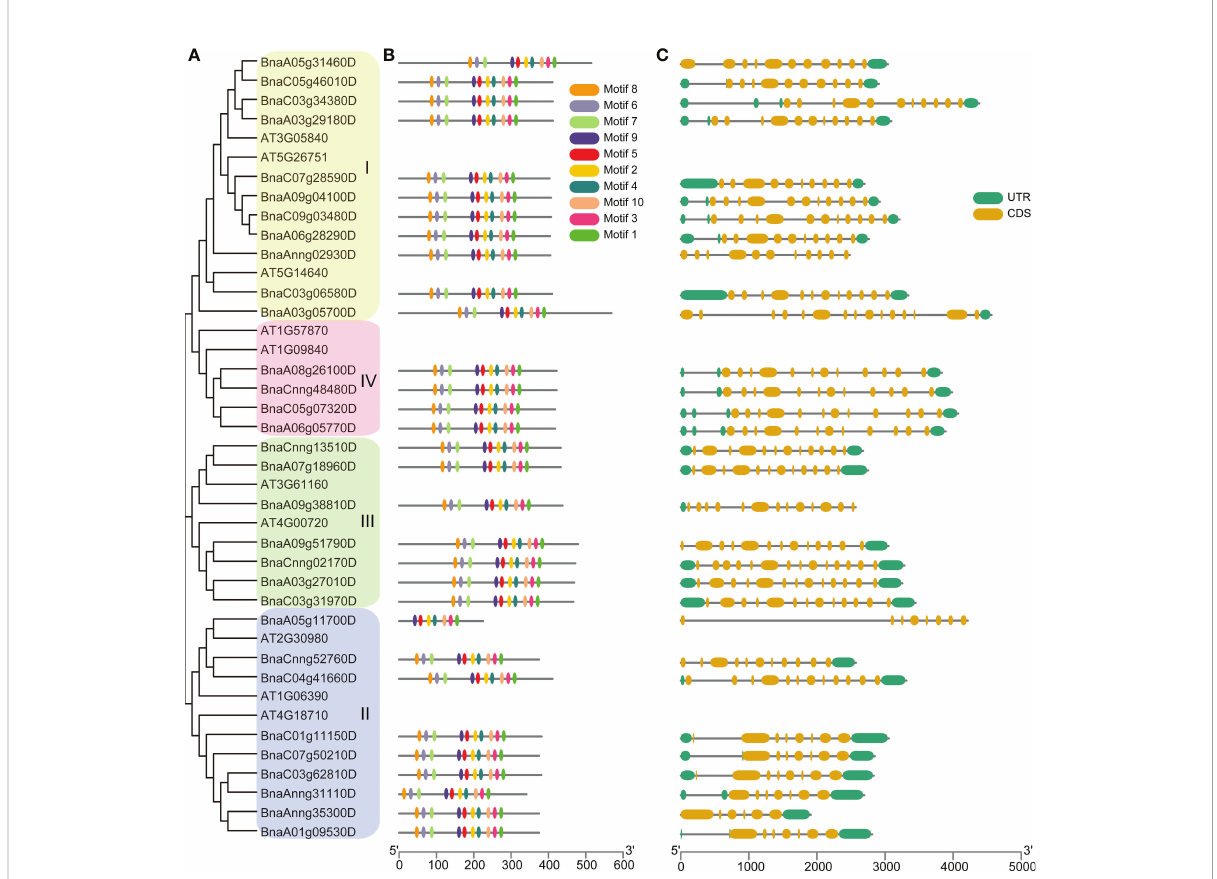
FIGURE 5 Gene structure and conserved motif analyses of AtGSK3s and BnGSK3s . (A) Phylogenetic tree of AtGSK3s and BnGSK3s . (B) Conserved motifs of AtGSK3s and BnGSK3s . (C) Gene structures of AtGSK3s and BnGSK3s